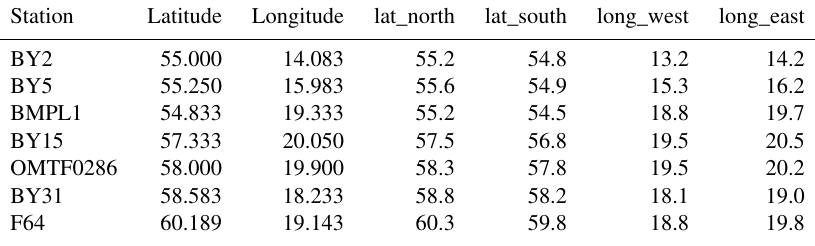
Table A1. Locations of oceanographic stations and borders of the corresponding boxes for selecting ICES observations ( ◦ N or ◦ E). Station Latitude Longitude